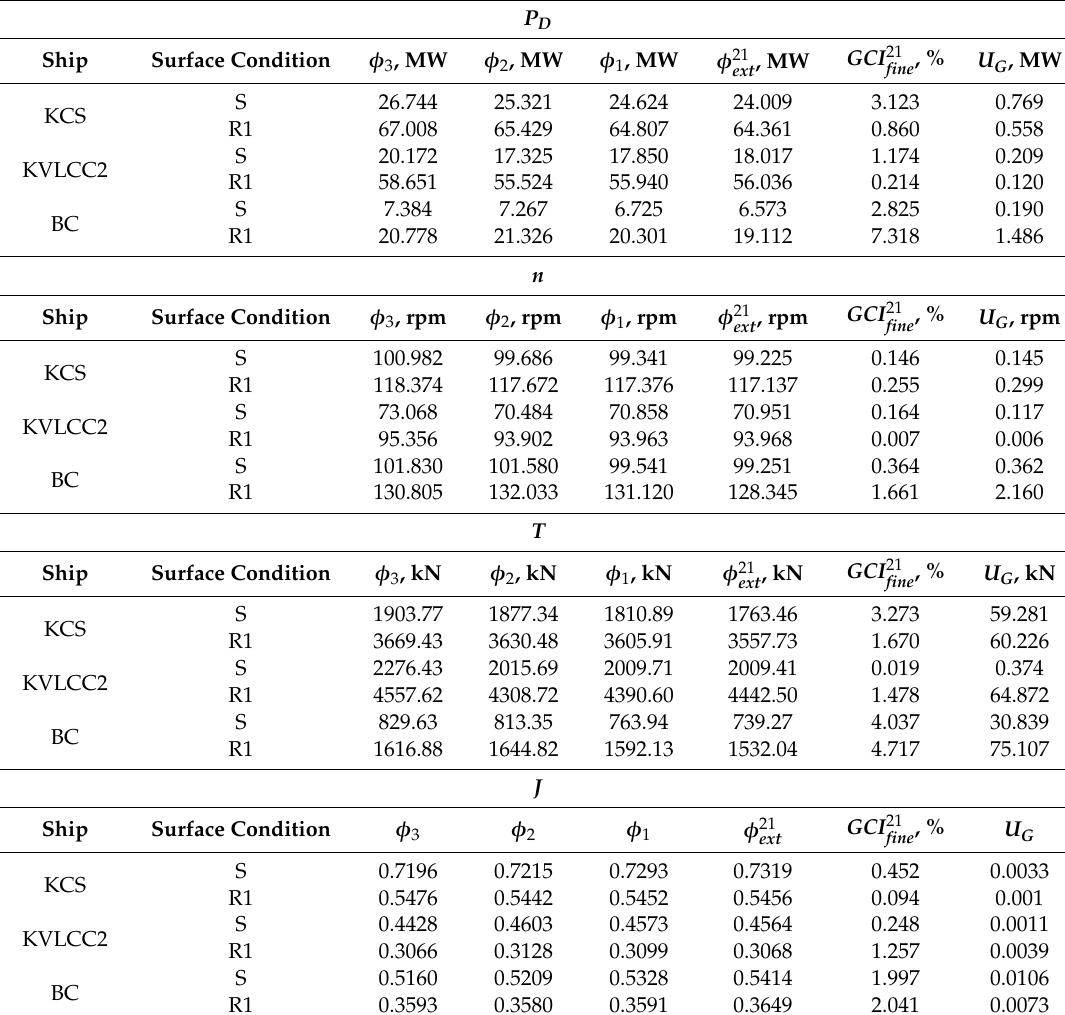
Table 7. The obtained grid uncertainties in the prediction of P D , n , T and J